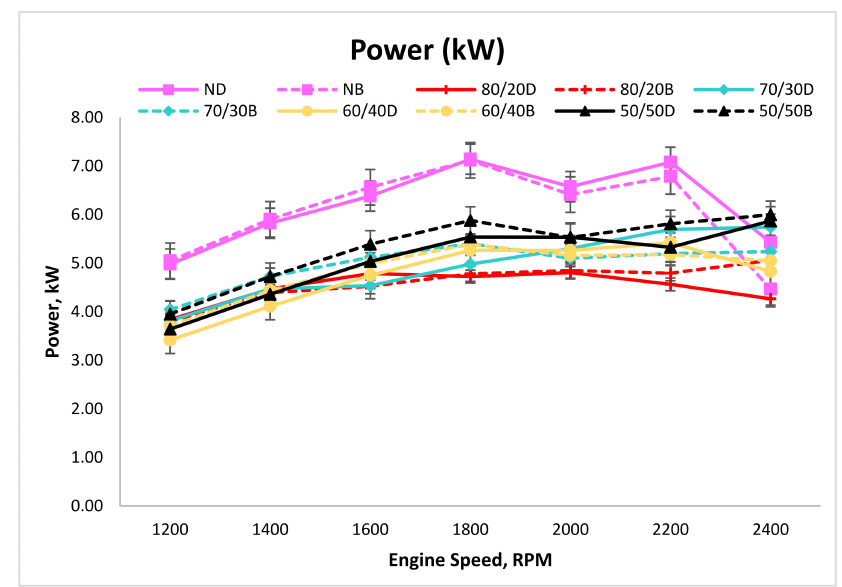
Figure 9. Power (kW) produced at various engine speed.